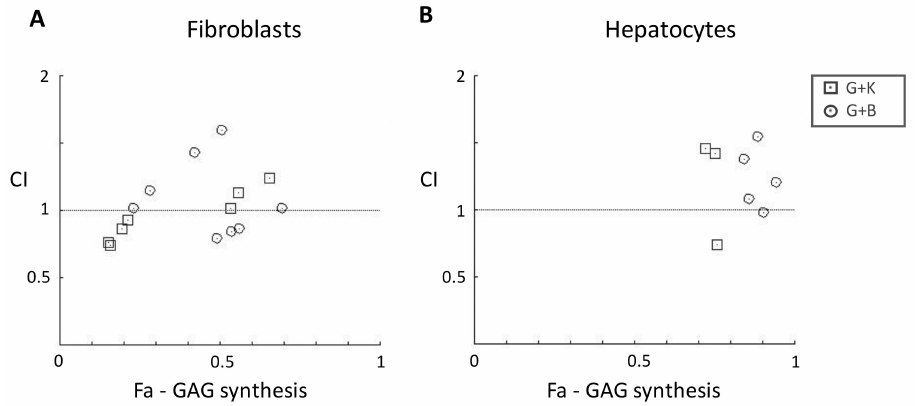
Figure 8. Combination index (CI) plot. CI values for various drug ratios are plotted against the fraction affected (Fa) values, i.e., the fraction of GAG synthesis inhibition obtained for fibroblasts ( A ) and hepatocytes ( B ). The dotted horizontal line represents the additive effect. CI values from actual data points are indicated by symbols. Fa—fraction affected, CI—combination index, G—genistein,